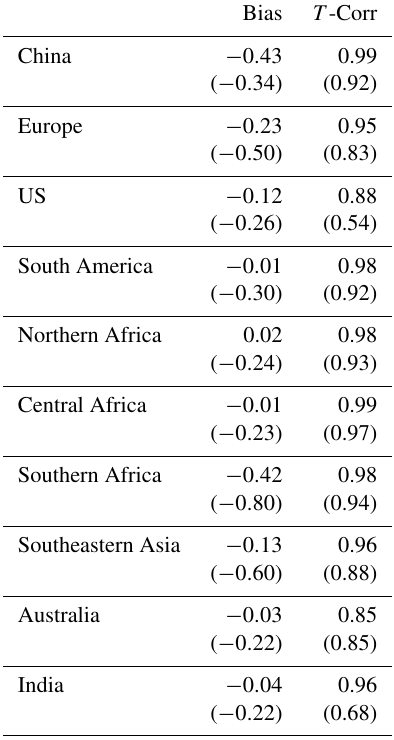
Table 4. The monthly mean bias and temporal correlation of re- gional mean tropospheric NO 2 columns: the data assimilation mi- nus the satellite retrievals from OMI for the period 2005–2018 in 10 15 molec . cm − 2 . The results of the model simulation (without data assimilation) are also shown in